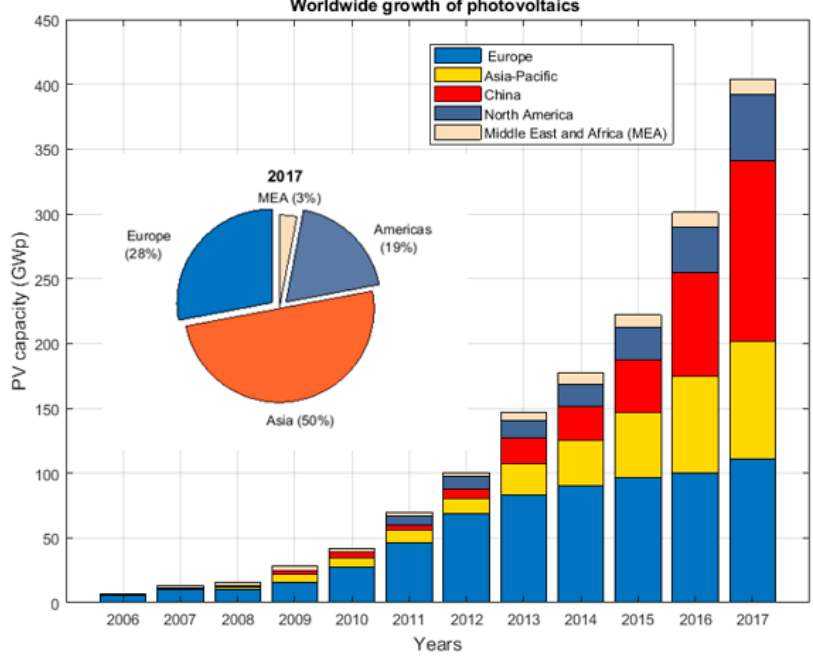
Figure 1. The worldwide growth of total photovoltaic (PV) systems installed from 2000 to 2017.